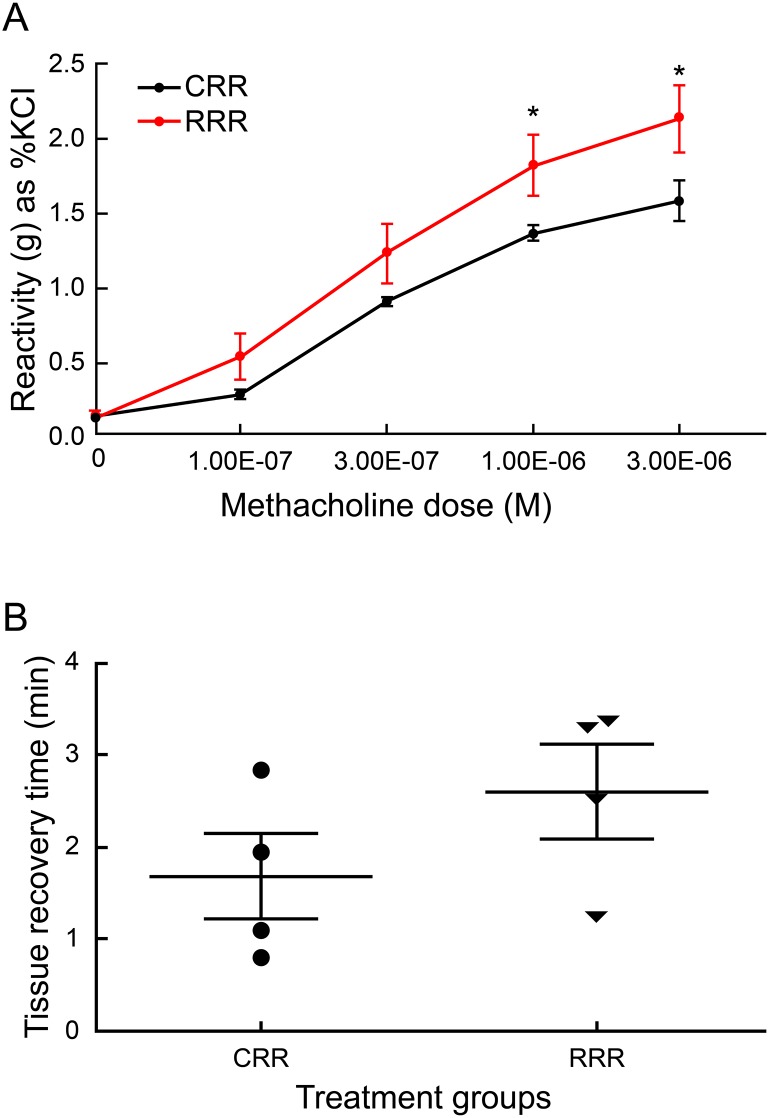
Prenatal rrRSV exposure is associated with hyperreactivity and prolonged contraction of lower airway smooth muscle.(A) Lower airway smooth muscle contraction in response to methacholine was measured ex vivo using tracheal segments harvested from 28-day old weanling rats during the peak of rrRSV LRTI. Baseline reactivity in response to KCl (80mM) was used to normalize data. (B) Tissue recovery time (TRT) required for the smooth muscle to return to baseline tone after a single 30-Hz pulse of electrical field stimulation was measured in minutes. Data for 3 experiments were combined and expressed as the mean ± SEM of 9 rats per group in Fig 7A, or 2 independent experiments combined and expressed as the mean ± SEM of 4 rats per group in Fig 7B. Two-tailed student’s t test: *P<0.05 compared to the CRR group.